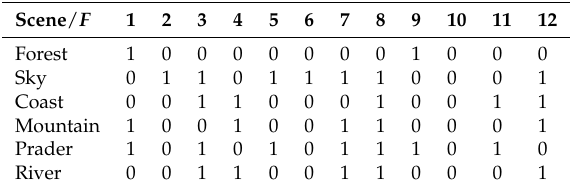
Table 4. The best individuals resulting from the evaluation of the GA per scenery.